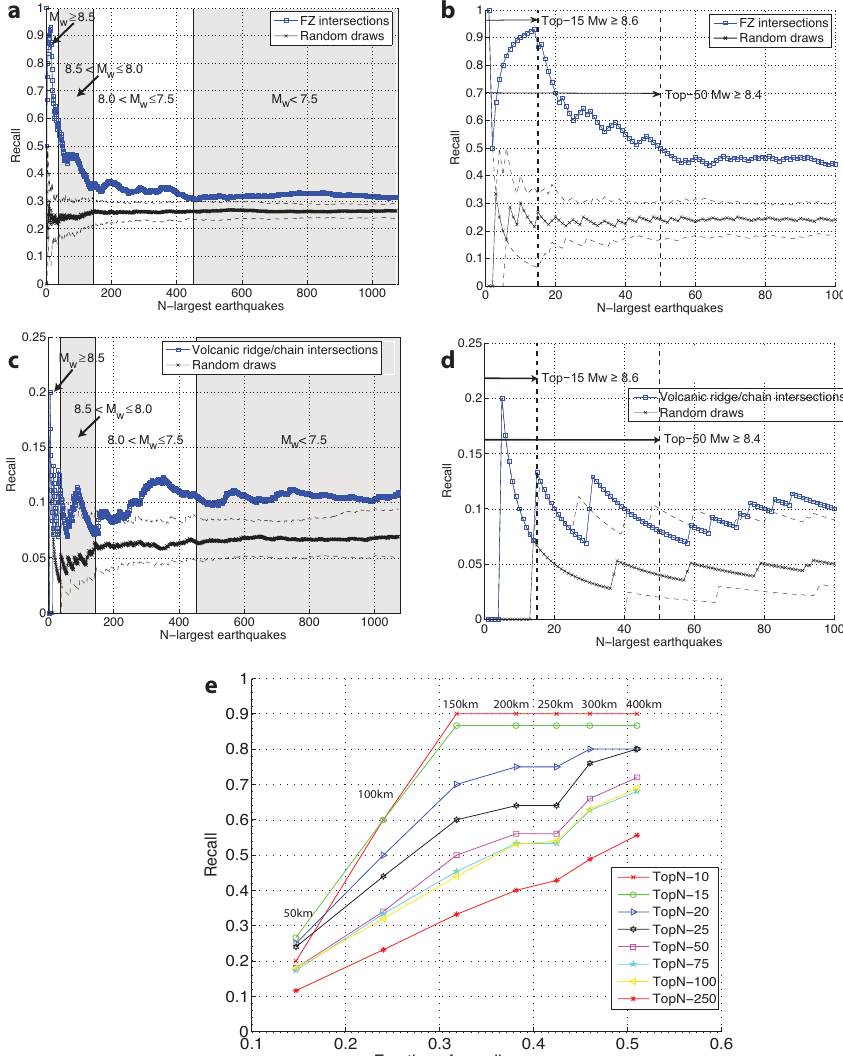
Fig. 2. (a) Evaluation of coupling-zone filtered earthquake associations with intersections between 59 fracture zones and subduction zones, sorted by magnitude N and using a buffer of 150km on either side of the projected fracture zone. The sorted event magnitudes are plotted against the recall , the number of Top-N earthquakes associated with the fracture zone intersection regions divided by N ; this is compared with the same number (59) of randomly generated subduction zone intersection segments drawn from the global coupling one, repeated 100 times for the entire filtered earthquake data set, shown as median values with the 20th/80th percentile error-bars; (b) same as (a) but for the top 100 ( M w ≥ 8 . 1) significant earthquakes; (c, d) same as (a, b) for volcanic ridge/chain intersections with subduction zones; (e) top-N great earthquake analysis in proximity of subduction zones illustrating the baseline-normalized recall (sensitivity) traded off against the reduction in hazard surface area (% of original hazard area, all subduction earthquakes), called the hazard specificity . Note the sharp inflection point for the top 15 earthquakes at 150km, illustrating that 87%, i.e. 13 out of 15 largest earthquakes, all occurred within 150km of a FZ–SZ